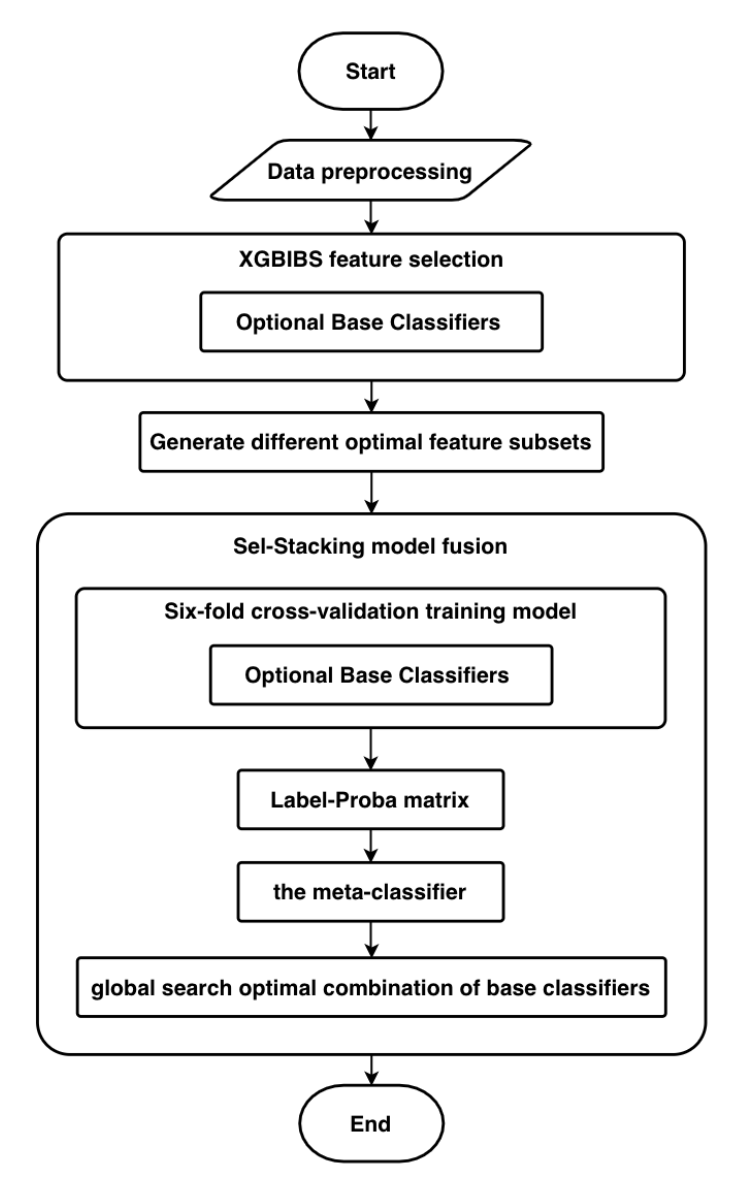
Figure 4. The flowchart of the XGB-Stacking